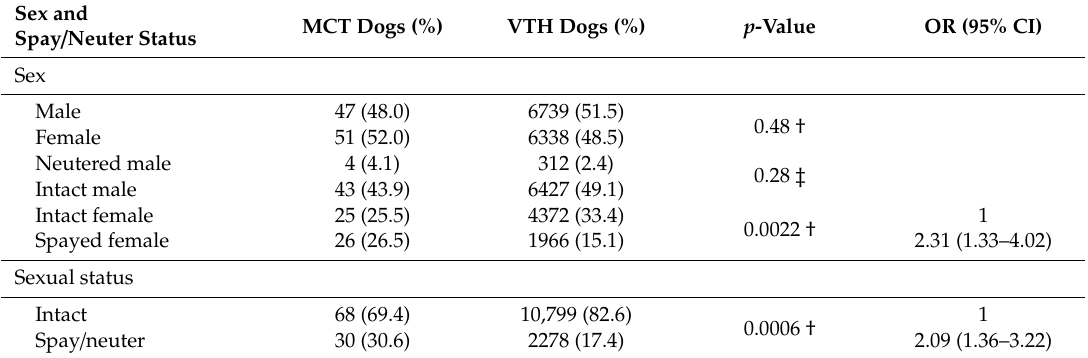
Table 2. Odds Ratios (OR) and 95% confidence interval for MCT frequency by sex and sexual status. Sex